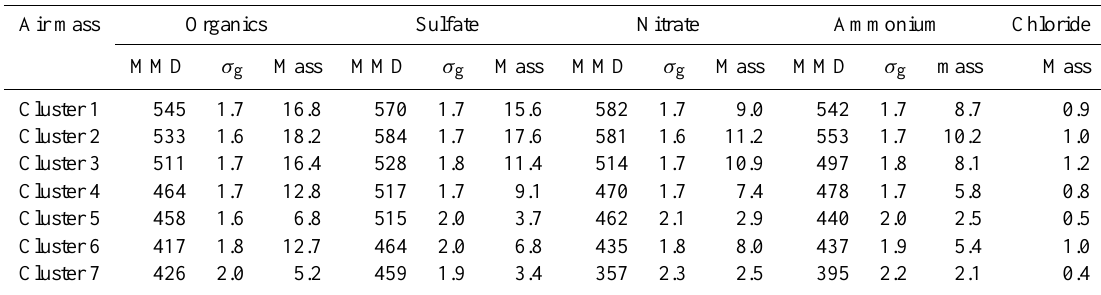
Table 2. MMDs (nm), standard deviations ( σ g ) , and mass concentration (Mass, µgm − 3 ) for chemical components in samples grouped by air-mass trajectory cluster.